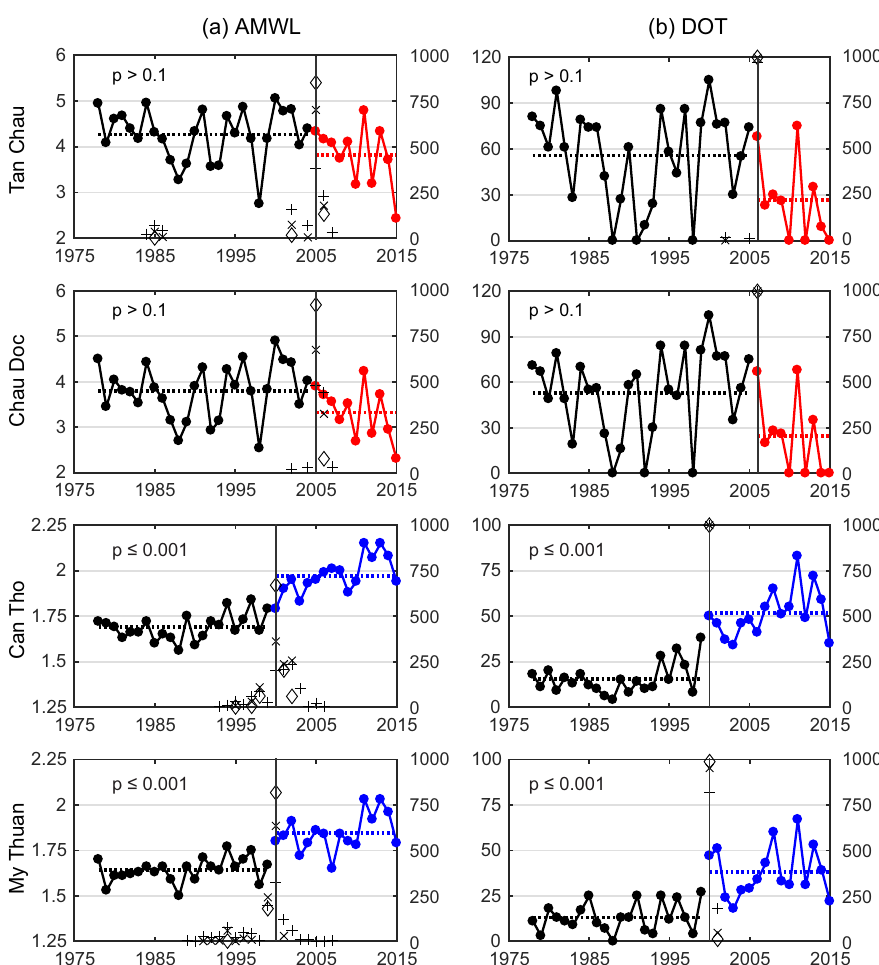
Figure 7. Step-change analysis including the uncertainty analysis at four stations in the VMD. Panel (a) presents results for annual maximum water level (in metres) and (b) for flood duration over thresholds (in days). Data before the change point are presented in black. The second period is presented in red for negative step change and in blue for a positive change. Dashed lines are mean values of partial datasets. Results of the uncertainty analysis are presented using the second vertical axis on the right, as the number of times that a step change occurred in a certain year at three error levels (5%: diamond; 10%: cross; 15%: